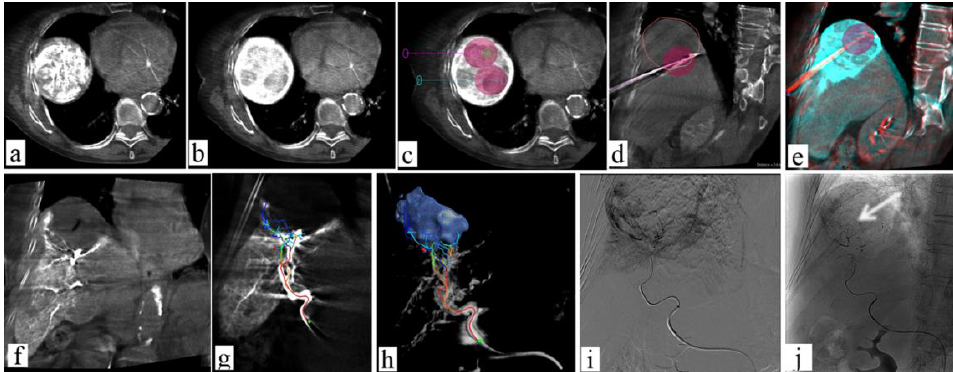
Figure 8. Seventy-eight-year-old female with very large HCC: combined therapy with MWA and TACE. ( a , b ) Large HCC lesion visualized with CBCT; ( c ) planning CBCT for ablation of HCC lesion, with volume ablation prediction; ( d , e ) fused images obtained using c.e. preprocedural CBCT and non-enhanced intra-procedural CBCT (red lines show large HCC lesion); ( f ) post-ablation contrast- enhanced CBCT with evidence of the ablation area and peripheral ipervascular tumor residual; ( g , h ) using Emboguide softwaere on CBCT imaging, the tumor feeders are identified; ( i ) angiographic images of microcatheter advancement on arterial feeders; ( j ) angiographic image after lipiodol-TACE of residual tumor demonstrates the lipiodol pooling on residual tumor (arrow).